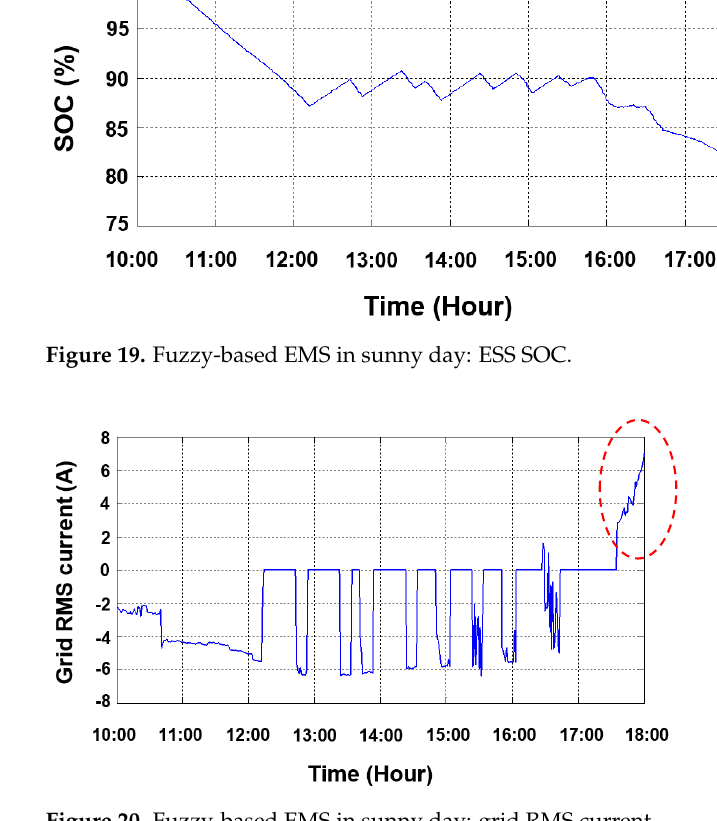
Figure 20. Fuzzy-based EMS in sunny day: grid RMS current.